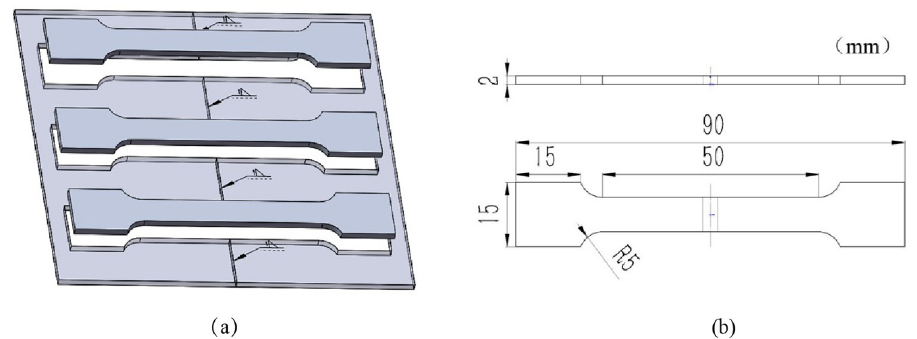
Table 2: Welding parameters of di ff erent cases